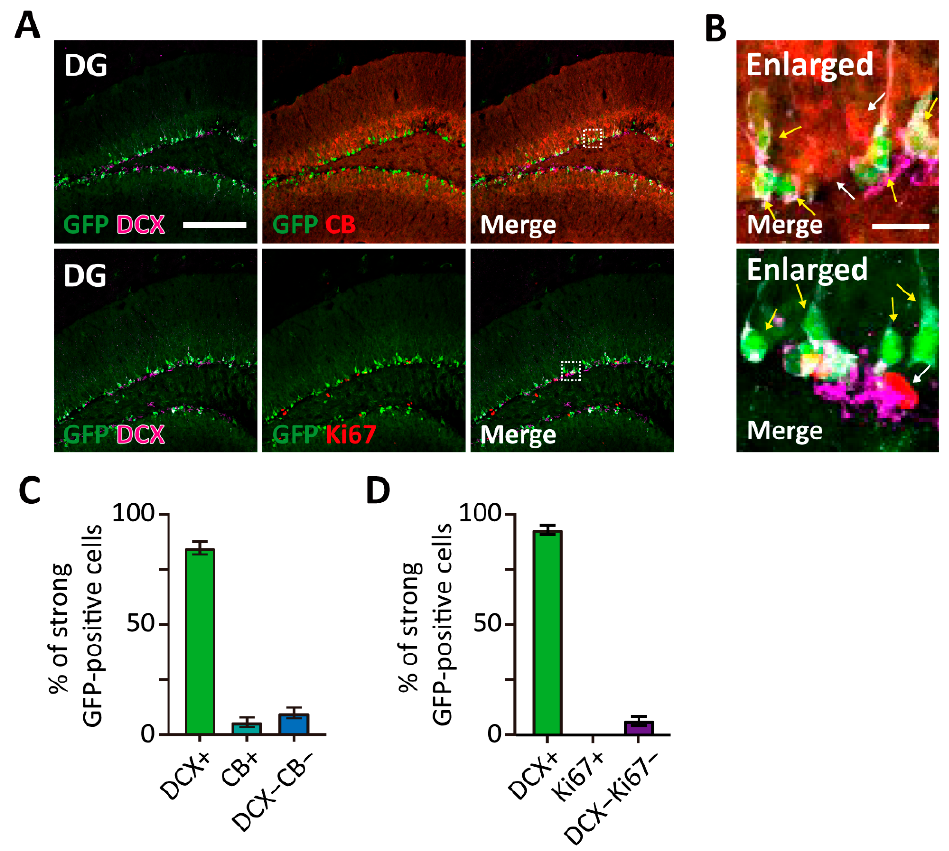
Figure 3. High TWIK-1 expression in immature neurons of the DG in TWIK-1 BAC-GFP Tg mice. ( A ) Representative co-immunofluorescence images with GFP, DCX, CB, and Ki67 in P56 of DG. Scale bar, 200 μ m. ( B ) Enlarged inset from A. Most of strong GFP-expressing cells co-labeled with DCX (yellow arrow), but not with CB and Ki67 (white arrow). Scale bar, 10 μ m. ( C , D ) Quantification of the cell type of strong GFP-expressing cells. Raw data are listed in Supplementary Materials Table S1. Data are presented as the Mean ± SEM.